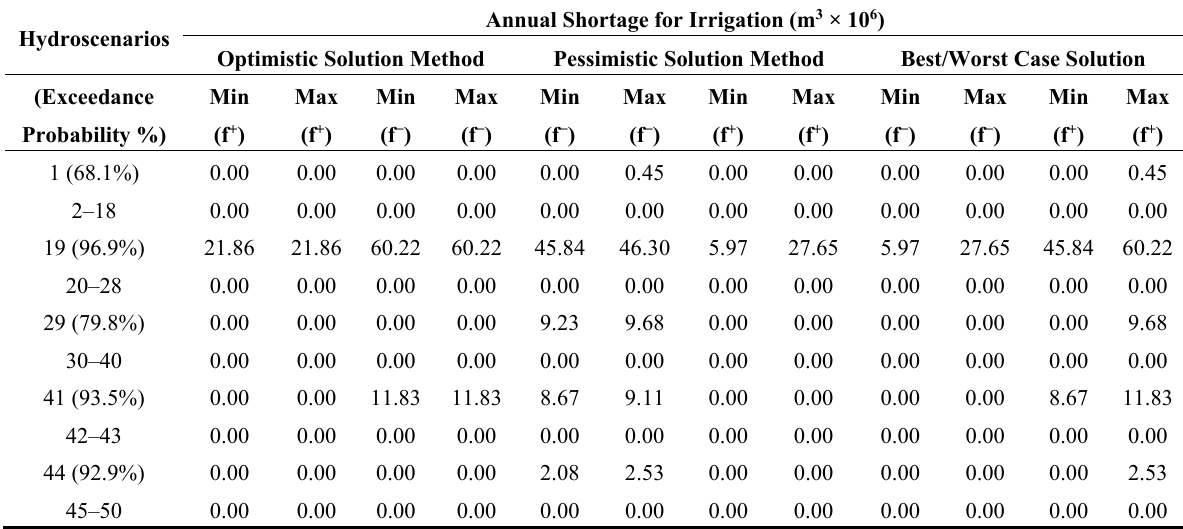
Table 13. Annual Shortage for irrigation (m 3 × 10 6 ).